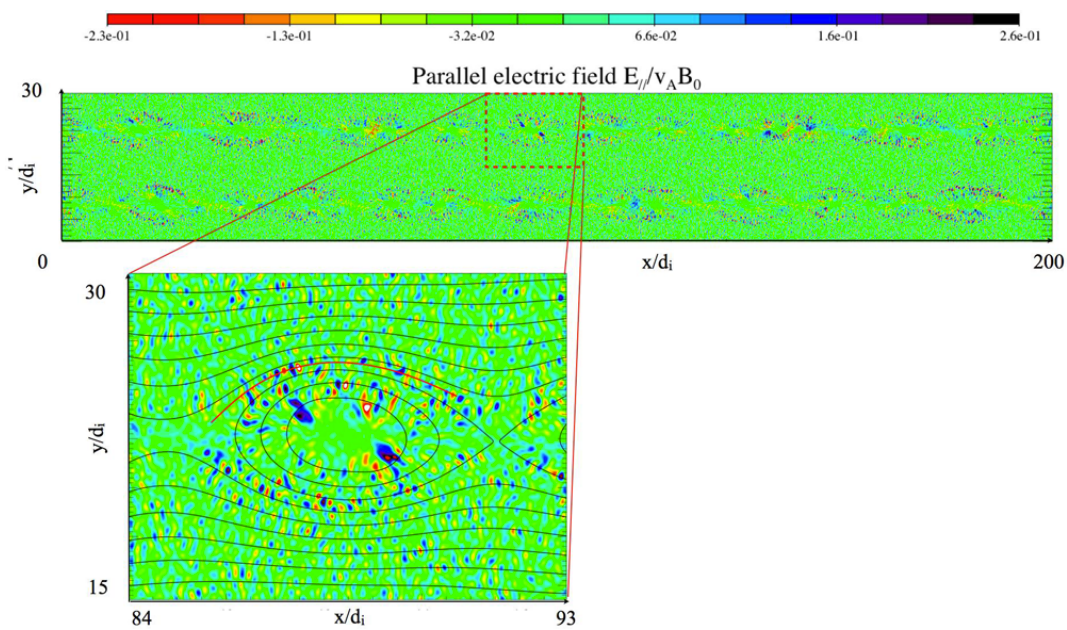
Fig. 8. Contour plot of the parallel electric field E // = E × B / | B | , normalized to the reconnection electric field B 0 V A /c with superimposed magnetic field lines in black at time (cid:127) ci t = 18 . 62 and enlargement of of a simulation region, x = 84–93, y = 15–30 enclosing a plasmoid. Bipolar parallel electric field signatures are localized in proximity of the magnetic